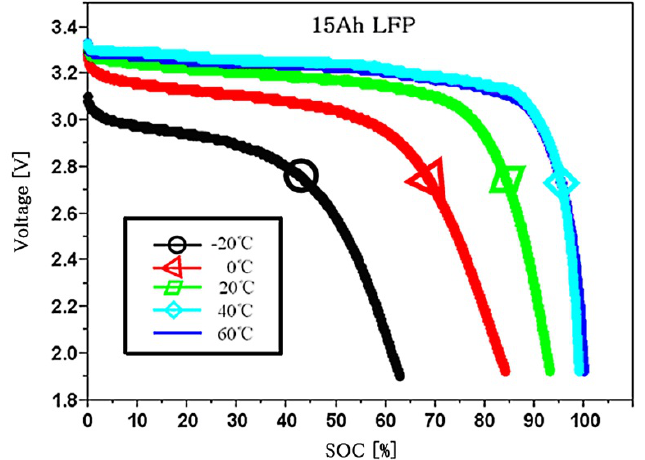
Figure 1. Capacity ratios under different